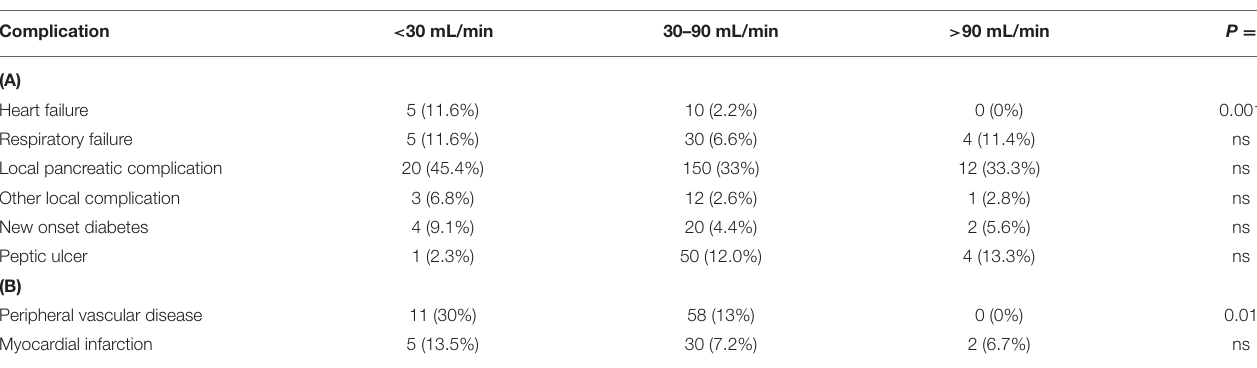
TABLE 4 | Complications of (A) acute pancreatitis, (B) vascular